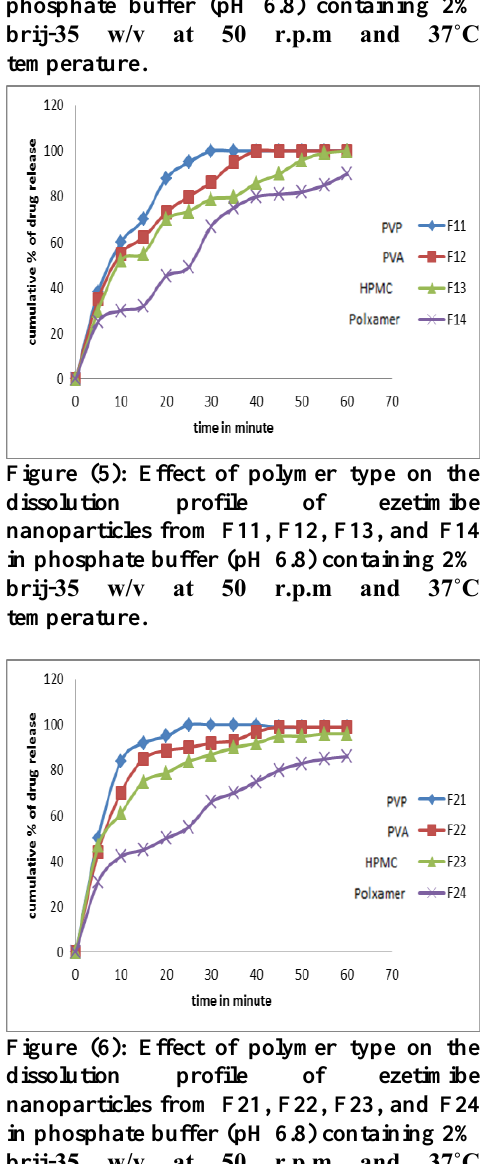
Figure (4): Effect of polymer type on the dissolution profile of ezetimibe nanoparticles from F1, F2, F3, and F4 in phosphate buffer (pH 6.8) containing 2% brij-35 w/v at 50 r.p.m and 37˚C temperature.